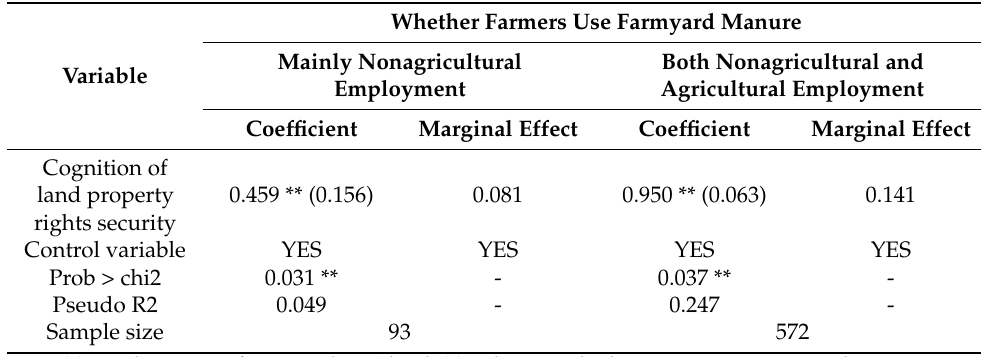
Table 5. Comparative analysis of farmers with different degrees of part-time employment.